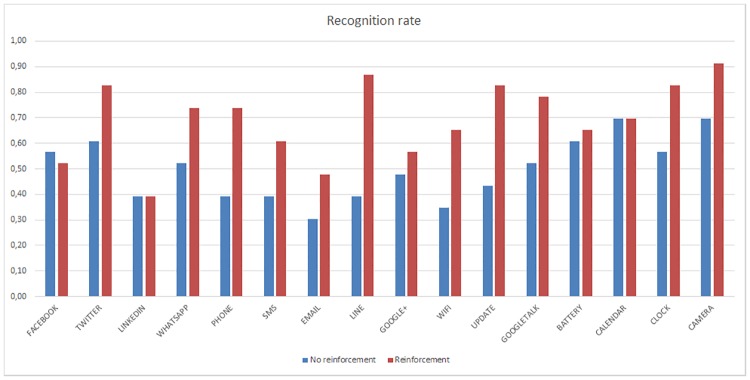
Per haptic icon recognition rate.Reinforcement vs No reinforcement for all the population.